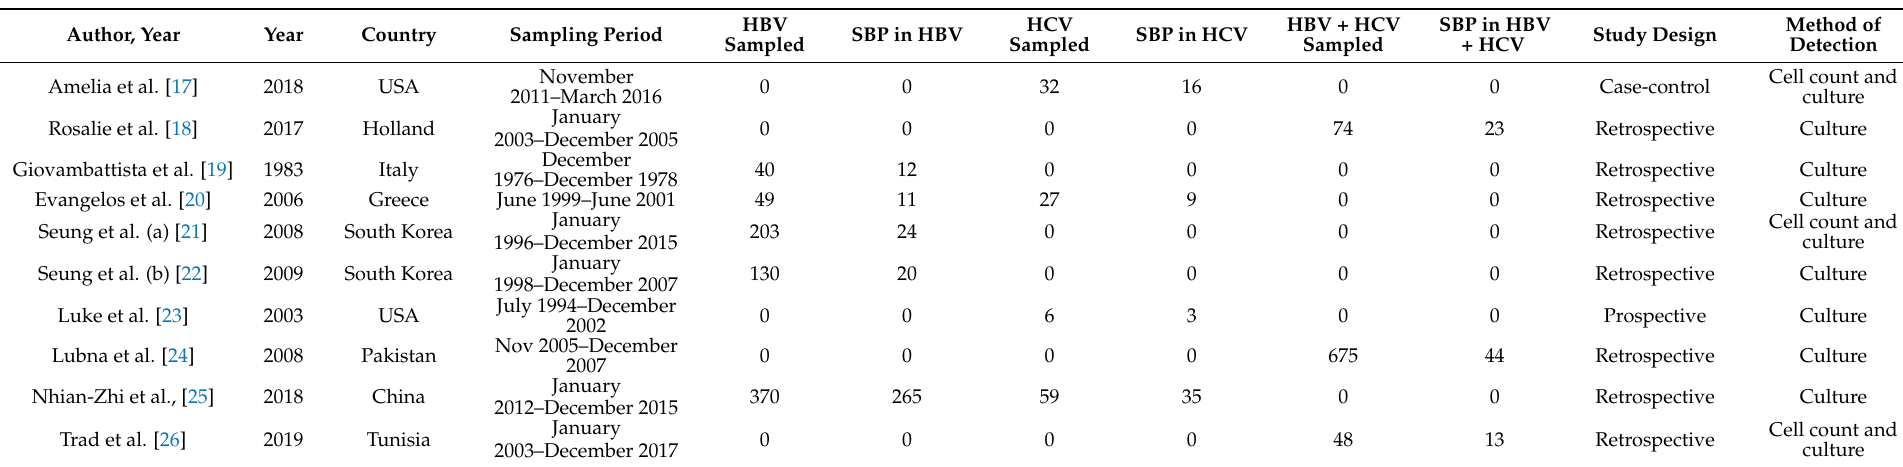
Table 1. Characteristics of the included studies showing the occurrence of SBP in HBV and HCV-related liver cirrhosis